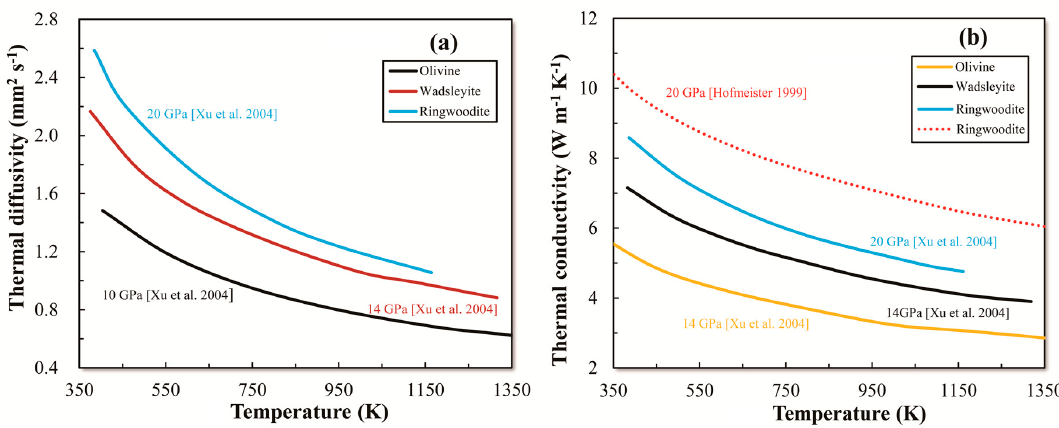
Figure 4. Temperature dependence of D and κ of wadsleyite and ringwoodte, according to Xu et al. [22]. ( a ): D . ( b ): κ . The dotted line data were calculated by Hofmeister [1]. The D and κ of ringwoodite also gradually decreased from approximately 2.6 mm 2 /s to 1.1 mm 2 /s and from 8.5 Wm − 1 K − 1 to 4.7 Wm − 1 K − 1 , respectively, with increasing temperature [22]. As shown in